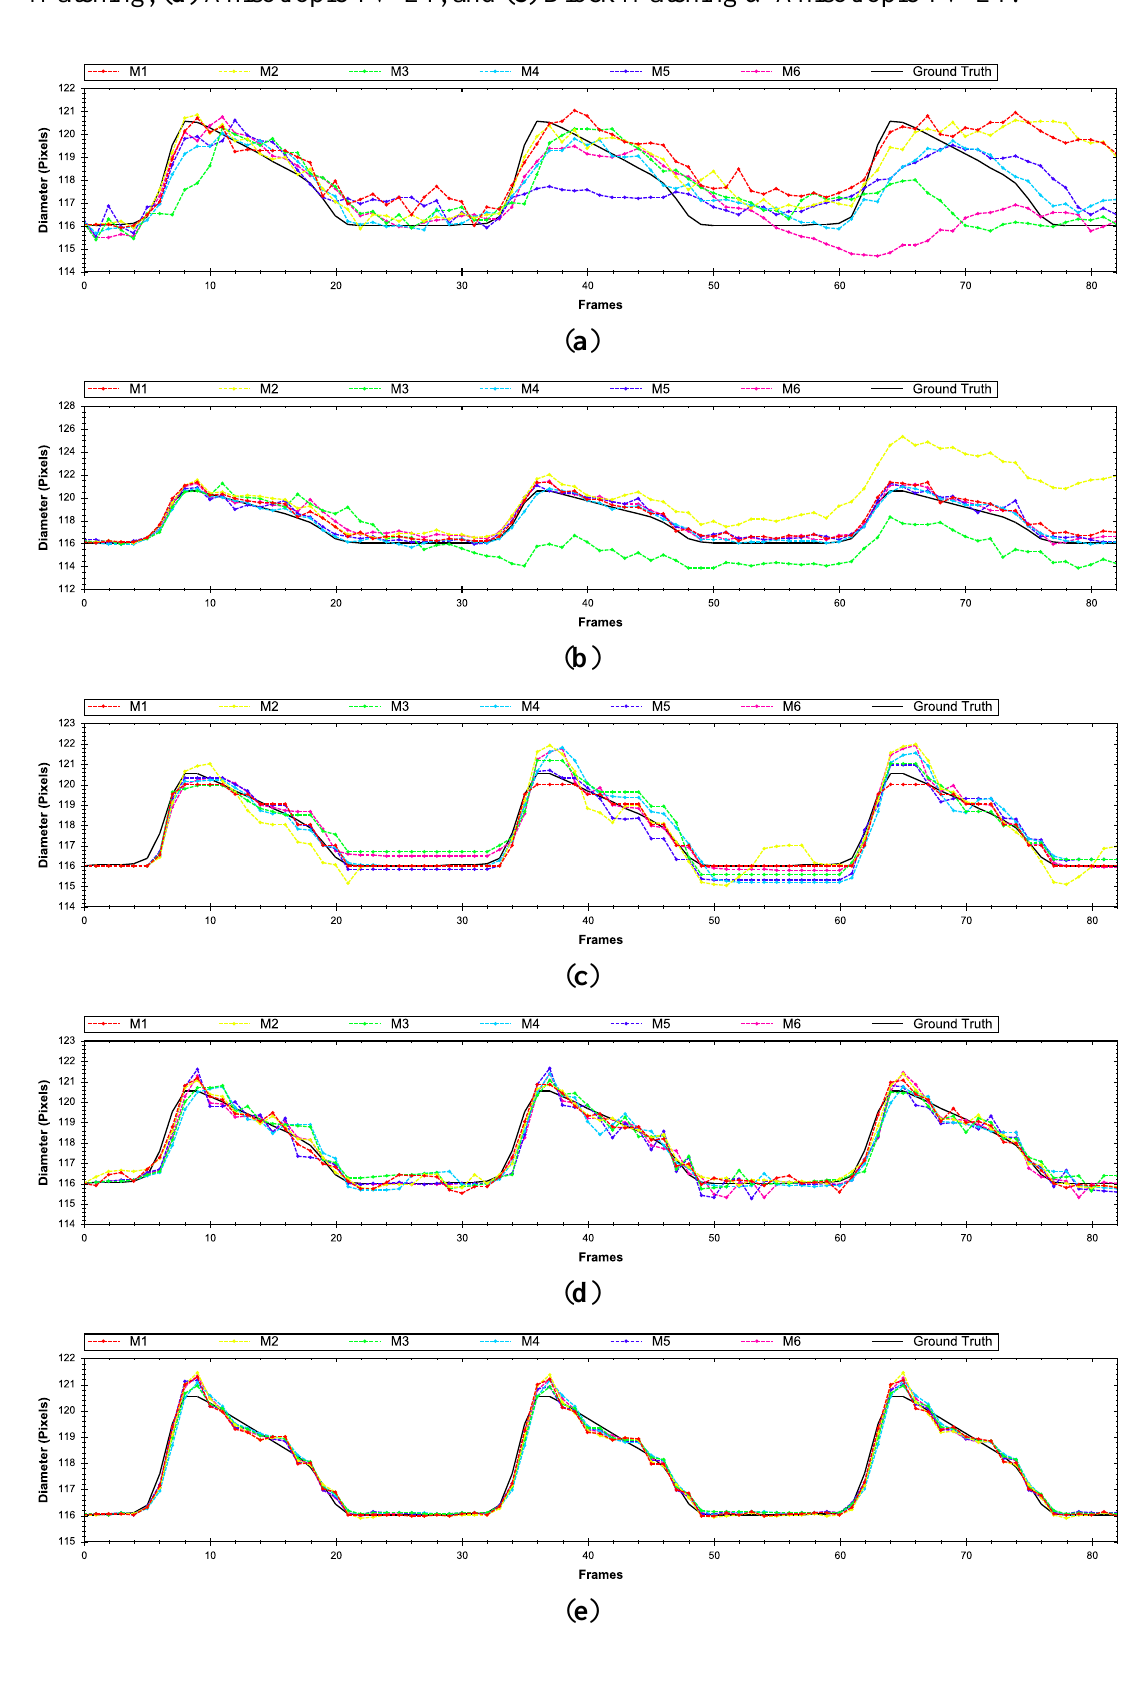
Figure 12. Diameter evolution over time evaluated in a sequence with small displacements evaluated with ( a ) Lucas-Kanade, ( b ) Block Matching & Lucas-Kanade, ( c ) Block Matching, ( d ) Anisotropic TV-L1, and ( e ) Block Matching & Anisotropic